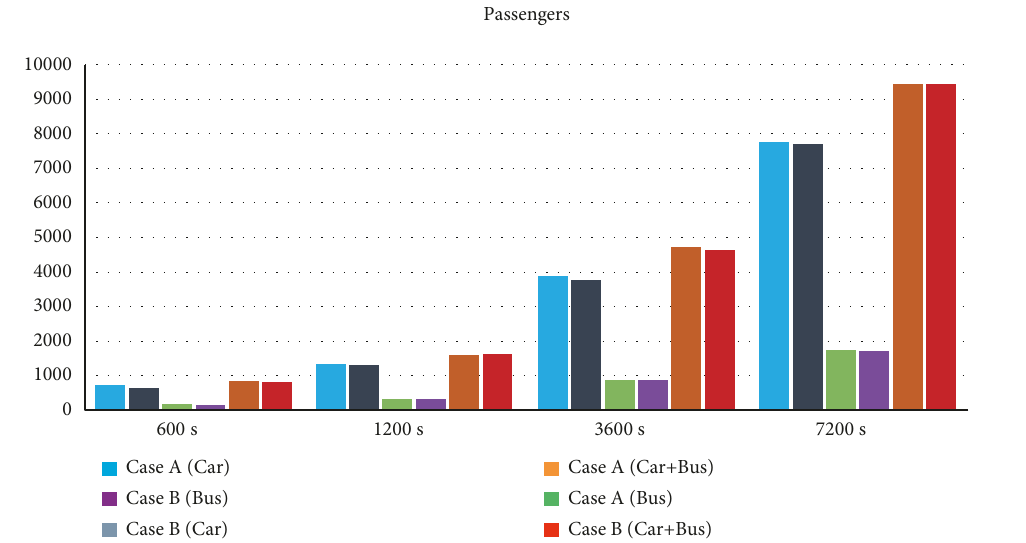
Figure 14: Passenger capacity in Group A and Group B.